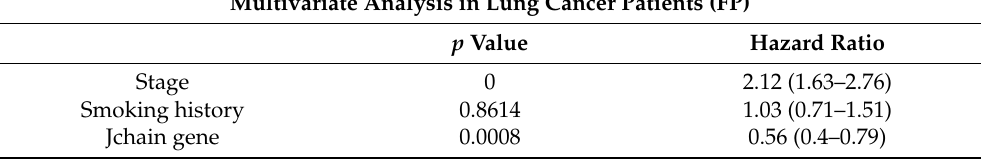
Table 5. Multivariate analysis considering first progression in lung cancer patients. Multivariate analysis of J chain gene expression and smoking history and stage on time to first progression in lung cancer (n = 453) patients.